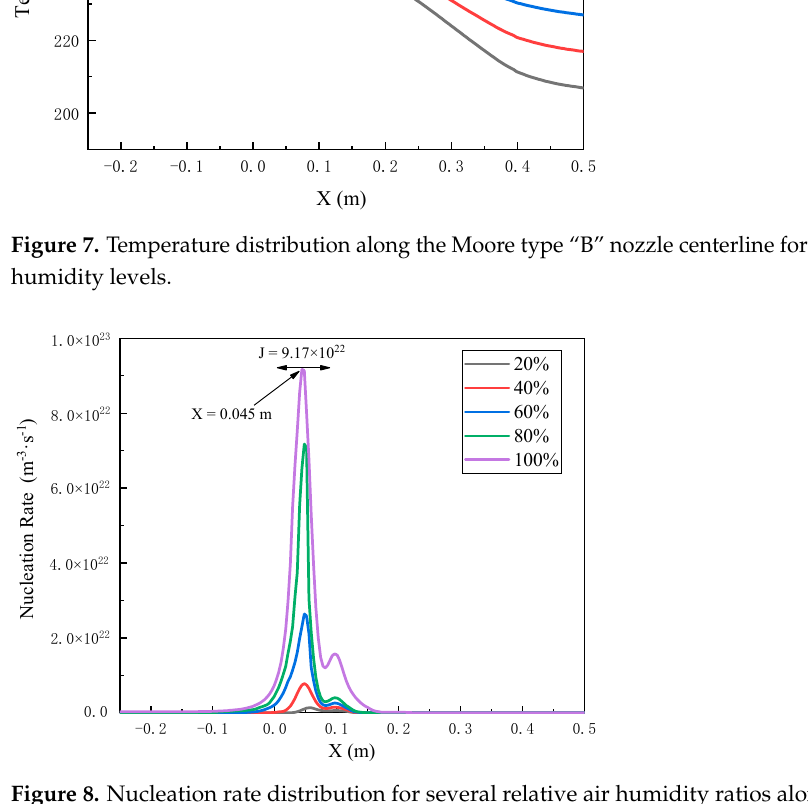
Figure 8. Nucleation rate distribution for several relative air humidity ratios along the Moore type “B” nozzle centerline.